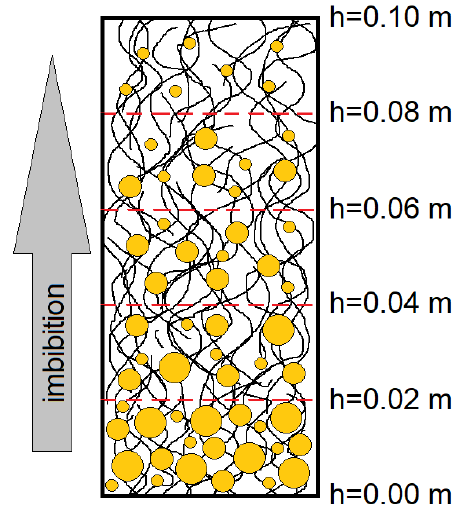
Figure 1. Partitioning of a porous material into